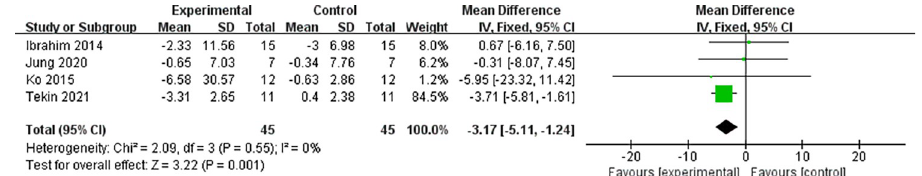
Fig 7. Effect of WBV training on TUG in children with cerebral